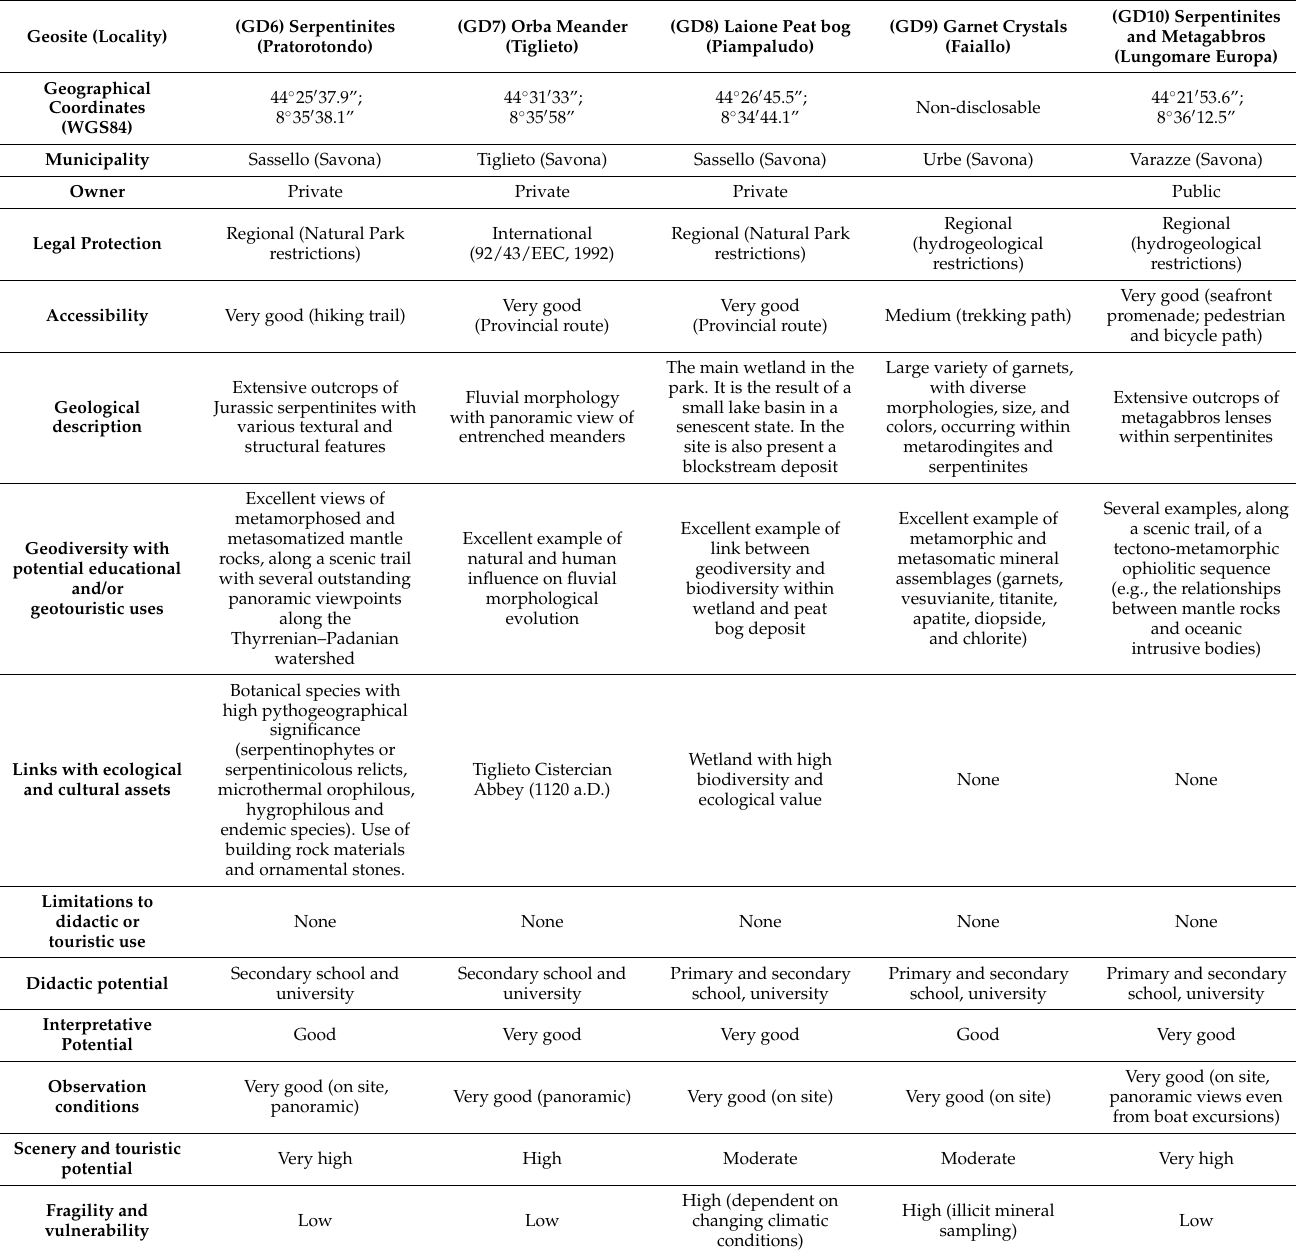
Table 2. Inventory and qualitative assessment of selected geosites (GD) from Beigua UGGp identified as of geological significance, but that are not currently on the ISPRA inventory [4], according to the criteria of Brilha (2016)